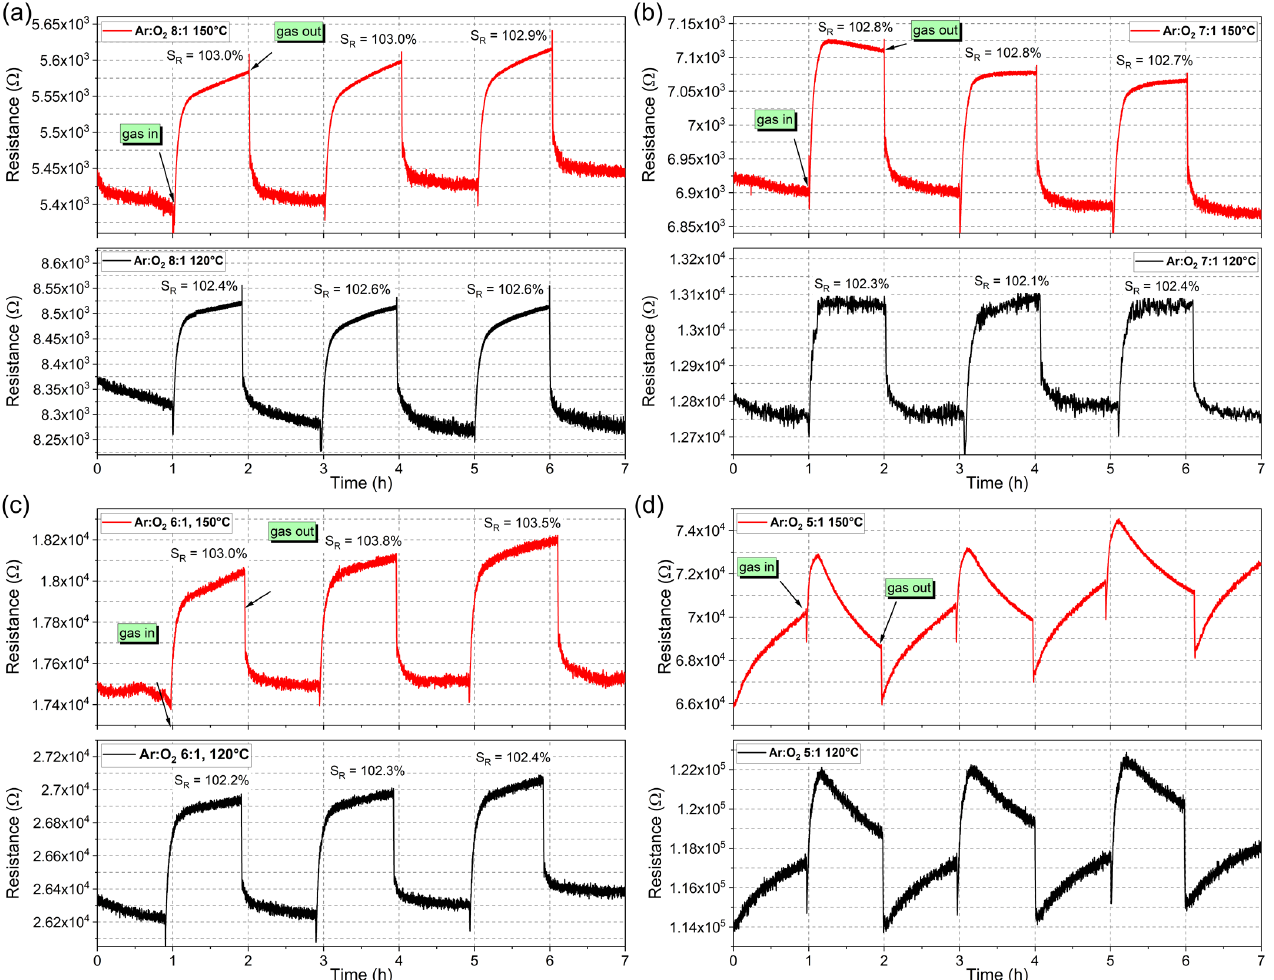
Figure 12. Gas response upon exposure to the 3.5% of hydrogen of as-deposited V x O y thin films